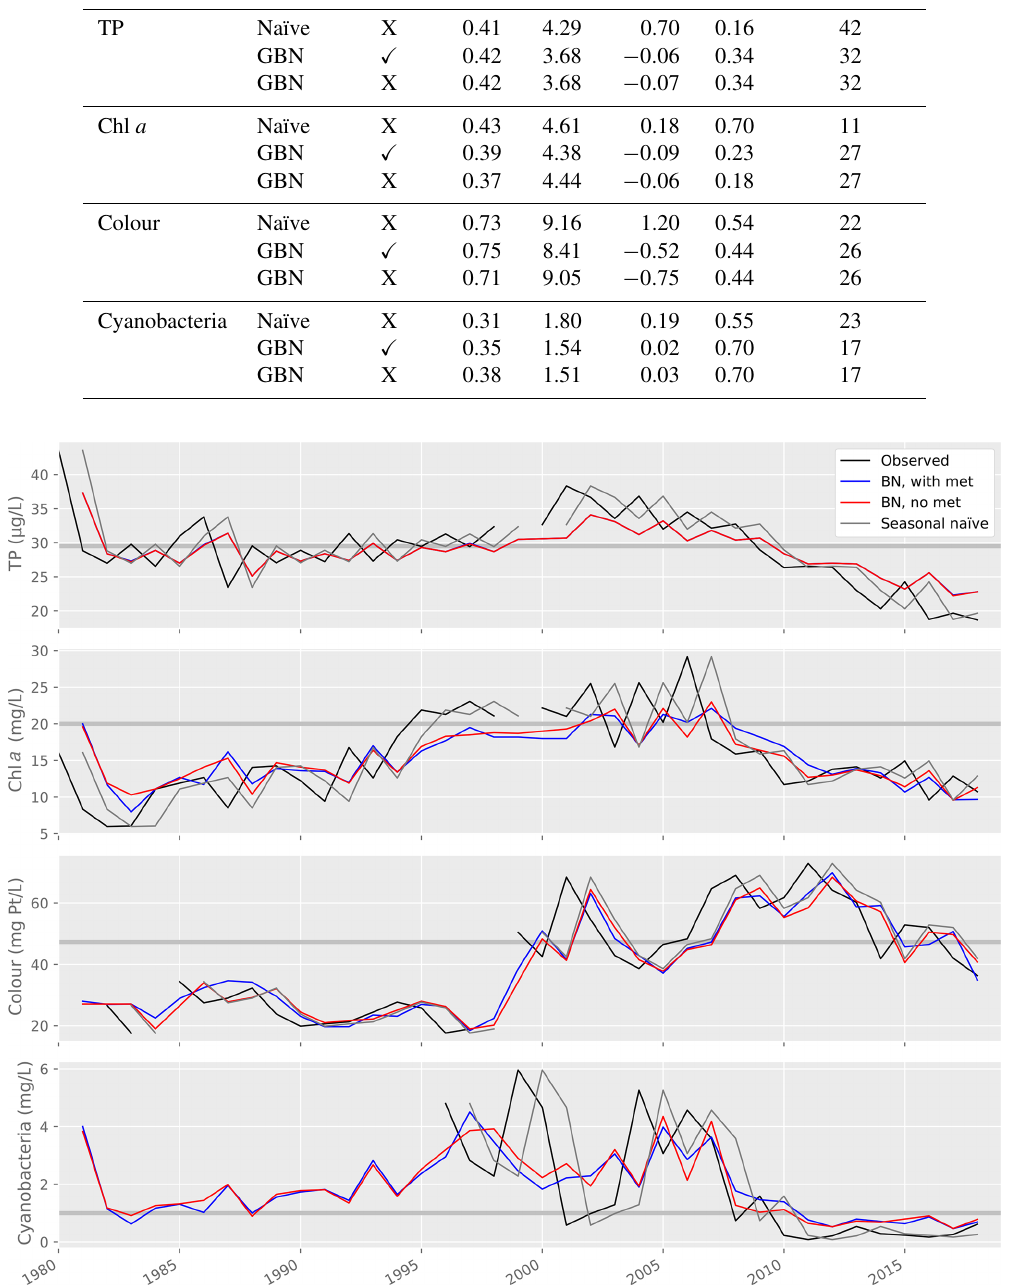
Figure 9. Lake water quality observations and predictions from a range of models, including the Gaussian Bayesian network (BN) with and without weather variables, and a seasonal naïve forecast. Horizontal grey lines show the thresholds used to classify predictions into two WFD-relevant classes (see Table